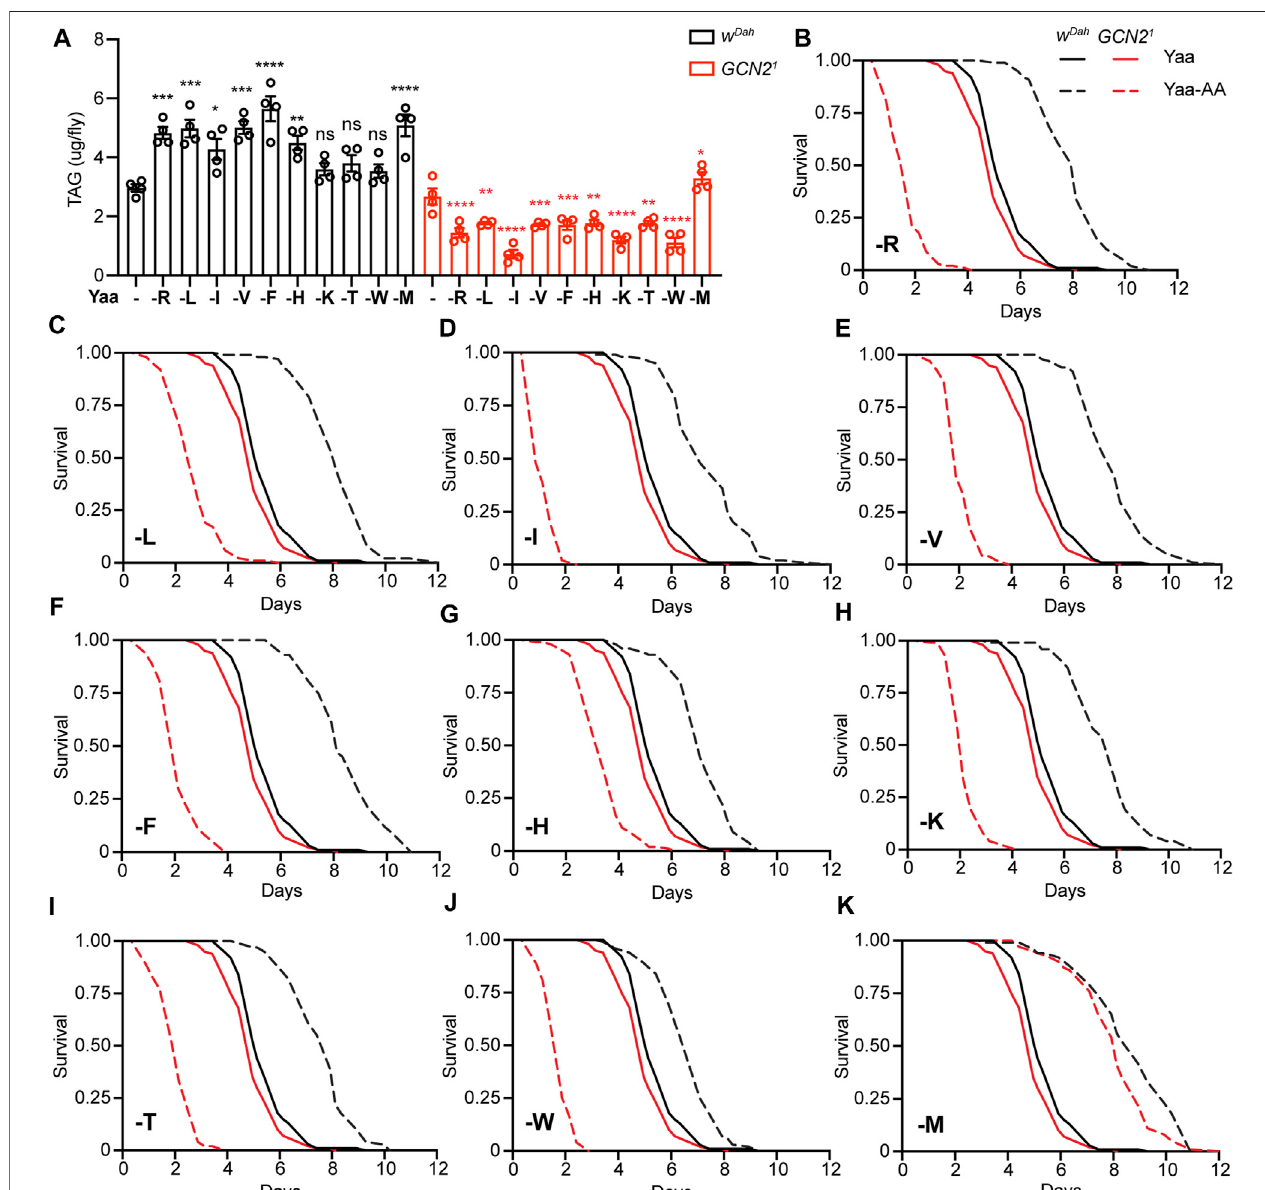
FIGURE 4 | Lipid content and starvation resistance of GCN2 mutant fl ies in response to EAA deprivation. (A) TAG content per fl y of w Dah and Gcn2 1 females upon deprivation of individual EAA. n = 4 replicates with fi ve females per replicate. Data are present as mean ± s.e.m. One-way ANOVA followed by Dunnett ’ s multiple comparisons test, p values were adjusted for multiple comparisons. (B – K) Survival under full starvation of w Dah and Gcn2 1 females. Flies were fed for 7 days with the indicated EAA-de fi cient diets followed by full starvation. Gcn2 1 mutants preconditioned on the standard Yaa diet were slightly shorter-lived than w Dah control fl ies ( p =6.8×10 − 3 ,log-ranktest). w Dah control fl iespreconditionedonEAA-de fi cientdietsshowedasigni fi cantlyincreasedstarvationwhencomparedtotheYaadiet:-R( p = 2.3×10 − 35 ,log-ranktest) (B) ,-L( p =3.4×10 − 37 ) (C) ,-I( p =5.2×10 − 24 ) (D) ,-V( p =5.2×10 − 34 ) (E) ,-F( p =7.7×10 − 40 ) (F) ,-H( p =1.9×10 − 23 ) (G) ,-K( p =2.6×10 − 29 ) (H) ,-T( p =3.3×10 − 29 ) (I) ,-W( p =2.3×10 − 13 ) (J) ,-M( p =1.1×10 − 38 ) (K) . Gcn2 1 mutantspreconditionedonmostEAA-de fi cientdietsshowedsigni fi cantlydecreased starvationresistancecomparedtotheYaadiet:-R( p =8.9×10 − 50 ,logranktest) (B) ,-L( p =1.7×10 − 36 ) (C) ,-I( p =3.9×10 − 52 ) (D) ,-V( p =1.1×10 − 49 ) (E) ,-F( p =2.7× 10 − 48 ) (F) ,-H( p =2.3×10 − 23 ) (G) ,-K( p =4.6×10 − 49 ) (H) ,-T( p =7.2×10 − 49 ) (I) ,-W( p =7.0×10 − 51 ) (J) .GCN2mutantspreconditionedwithM-deprivedfoodshowed increasedstarvationresistancecomparedtotheYaadiet:-M( p =3.4×10 − 38 ) (K) log-ranktest.Survivalcurvesof w Dah and Gcn2 1 ontheYaacontroldietarethesamein (B – K) . n = 100 fl ies per genotype and